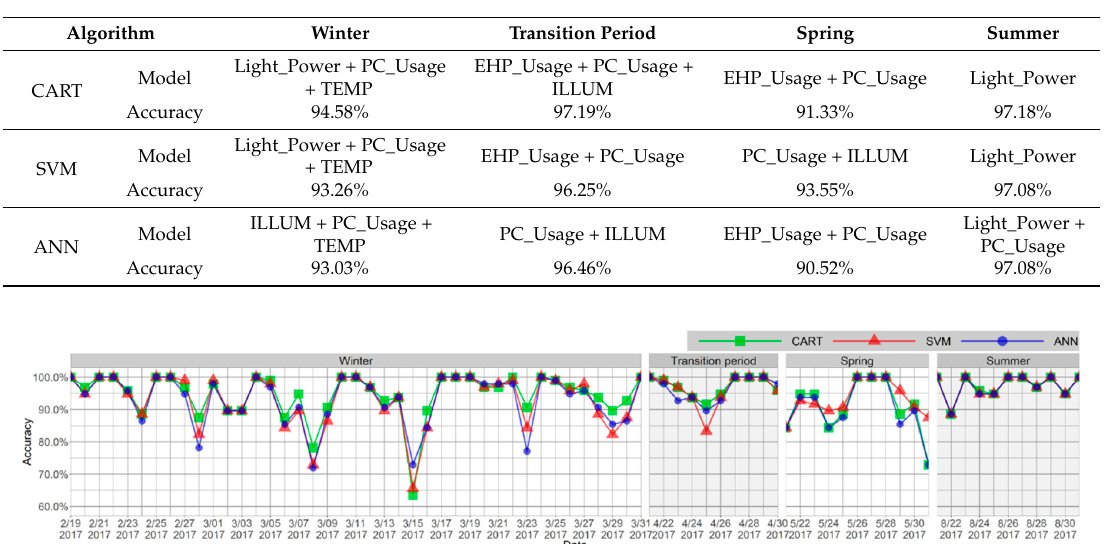
Table 8. Selected final classification models and their accuracies for classification algorithms by seasons.